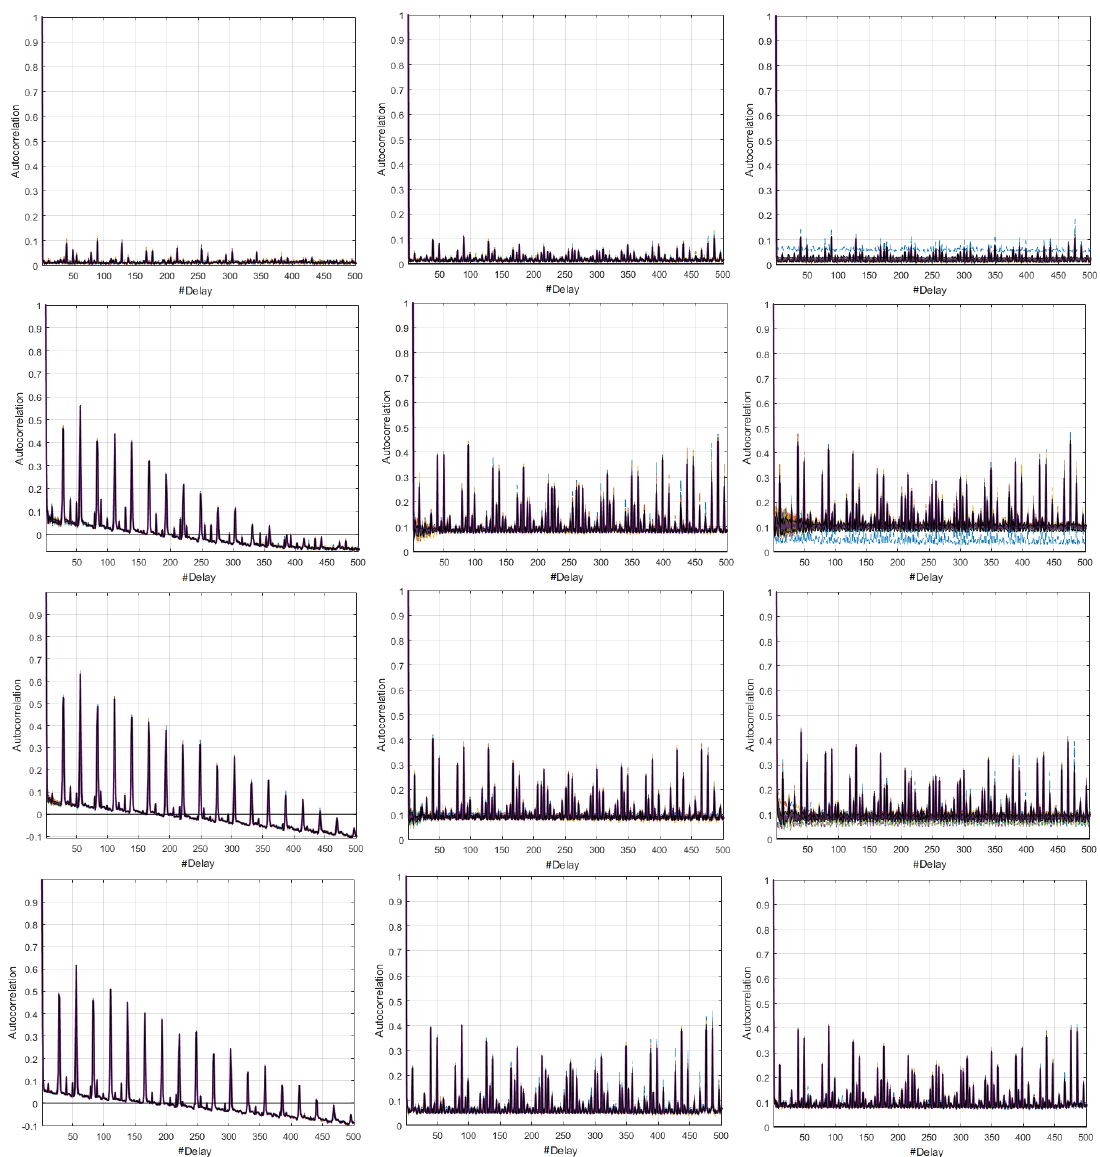
Figure 15. CI of SAF for ZigBee network. From left to right: 9600, 19,200, and 57,600 bauds. From top to bottom: Coordinator Nodes, and Nodes